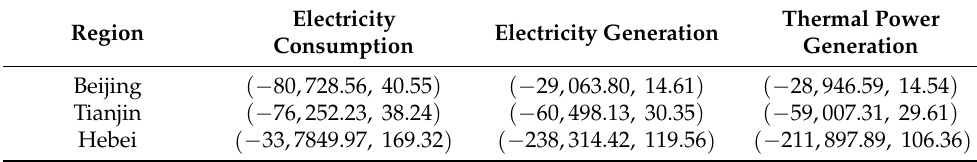
Table 3. Coefficient table of energy-related prediction functions ( α , β